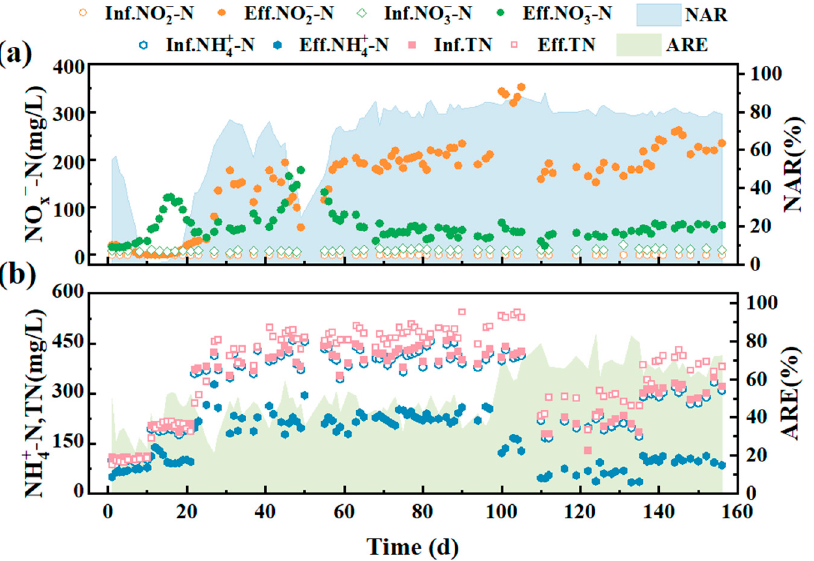
Figure 4. Operation performance during the entire PN process. ( a ) Concentration of nitrite and nitrate in influent and effluent, and the rate of nitrite accumulation; ( b ) concentration of ammonia and TN in fluent and effluent, and ammonia removal efficiency.